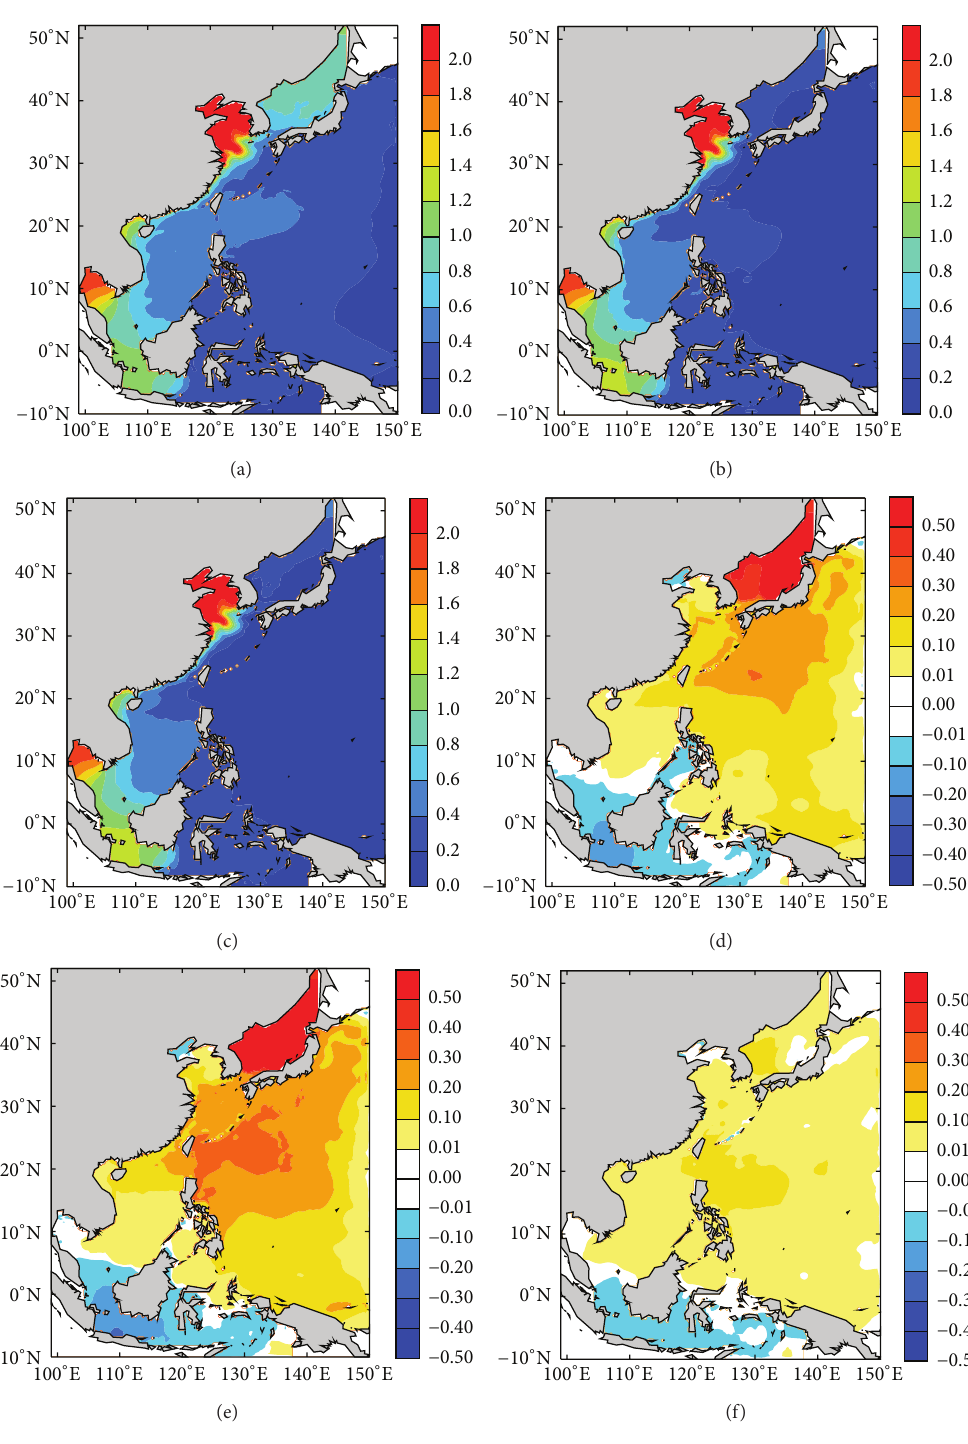
Figure 4: Similar to Figure 3 but for salinity. Unit: